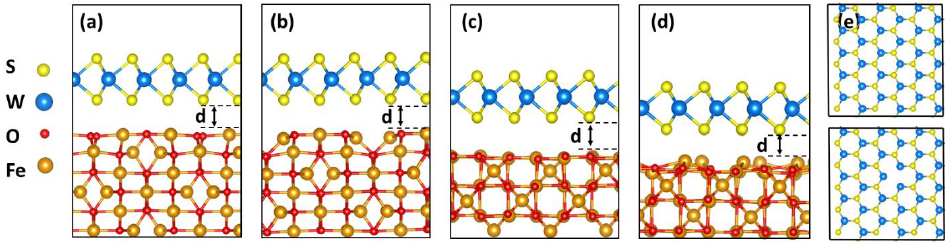
Figure 3. Side view of the simulated Fe 3 O 4 (110)/WS 2 heterostructures: ( a ) B-terminated cubic Fe 3 O 4 ; ( b ) AB-terminated cubic Fe 3 O 4 ; ( c ) B-terminated monoclinic Fe 3 O 4 ; ( d ) A-terminated monoclinic Fe 3 O 4 . ( e ) Top view of WS 2 and WS 2 (V S-S ) with two adjacent S vacancies.